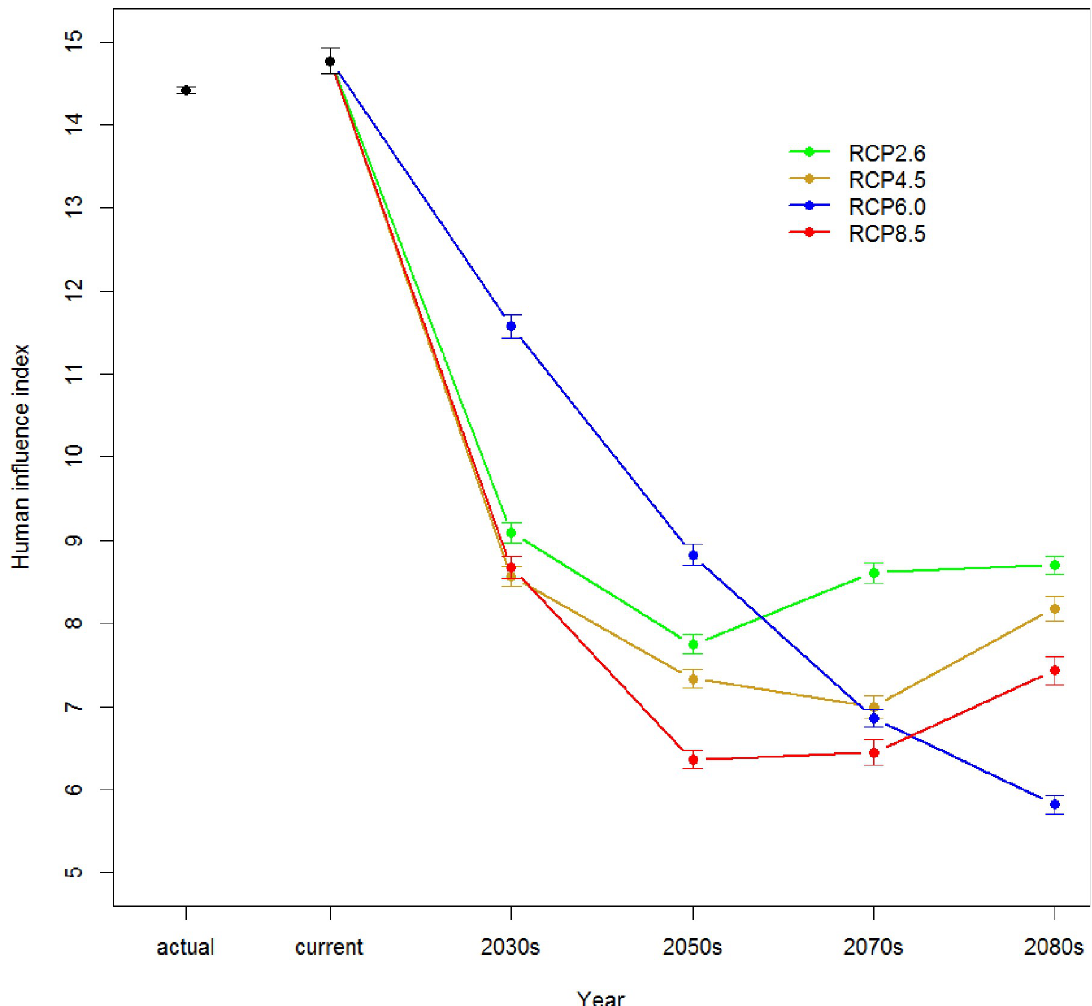
Fig 7. Average human influence index in actual breeding area and predicted breeding area under climate change. (Error bars show 95% confidence interval of average human influence index).